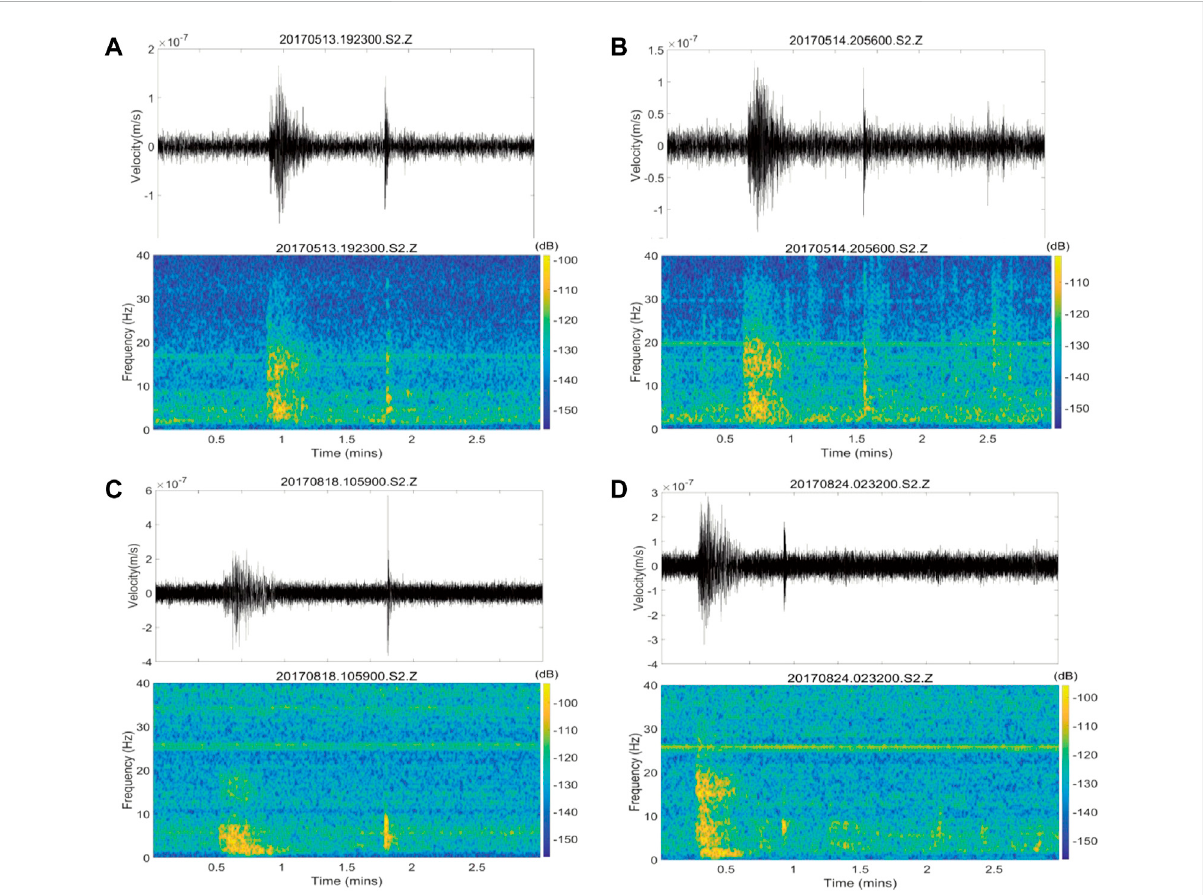
FIGURE 4 TimefrequencyanalysisoftheZ-componentofthefourpairedsignalsatstationS2.Thetoponeisthewaveformandthebottomoneisthetime frequency spectrogram of the corresponding waveform. (A) The paired signal on 13 May 2017, 19:23:00 UTC. (B) The paired signal on 14 May 2017, 20:56:00 UTC. (C) The paired signal on 18 August 2017, 10:59:00 UTC. (D) The paired signal on 24 August 2017, 02:32:00